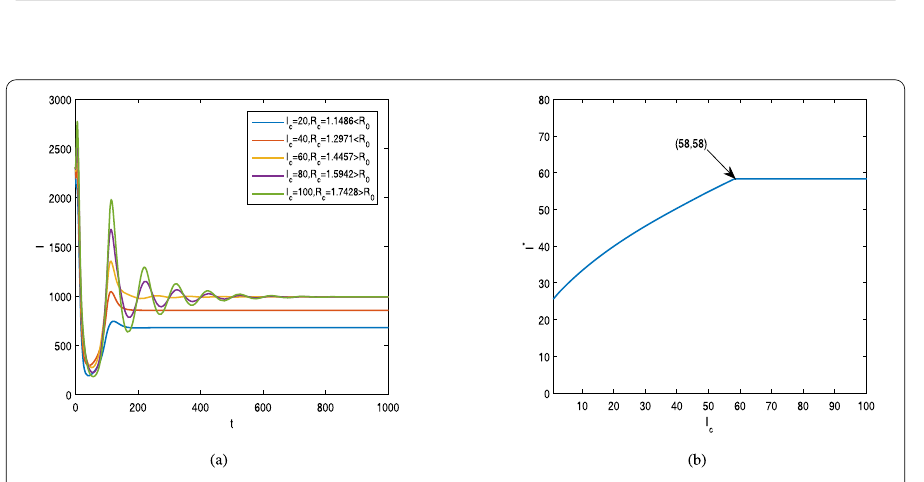
(cid:25) (cid:2) I ( x , t ) dx in terms of different I c ; ( b ) The variable I